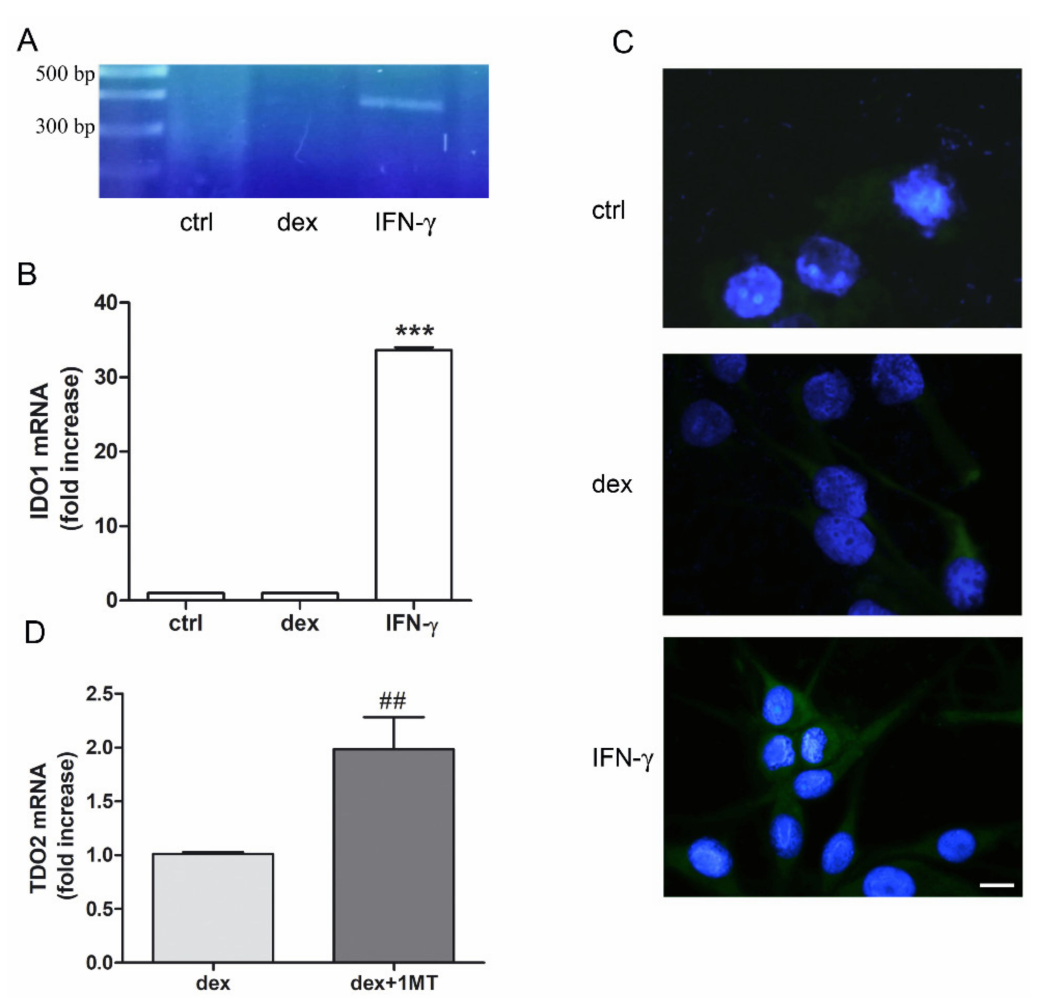
Figure 3. Modulation of IDO1 and TDO2 by interferon gamma (IFN- γ ) or dex. ( A ) Cells were treated without (ctrl) or with dex (25 µ M) or with IFN- γ (50 ng/mL) for 24 h. Total RNA was then isolated, and RT-PCR-generated cDNA of IDO1 was subjected to agarose gel electrophoresis. ( B ) Cells were treated without (ctrl) or with dex (25 µ M) or with IFN- γ (50 ng/mL) for 24 h. Total RNA was then isolated, and real time PCR was performed. Data represent mean ± SEM, ( n = 4; *** p < 0.001 vs. control unstimulated (ctrl) cells). ( C ) Cells were treated without (ctrl) or with dex (25 µ M) or with IFN- γ (50 ng/mL) for 24 h, followed by immunofluorescence for IDO1 expression (IDO1: green; nuclei: blue). Representative photomicrographs at 40 × magnification are shown. Scale bar 20 µ m. ( D ) Cells were treated with dex (25 µ M) in the presence or absence of 40 µ M 1-MT, an IDO inhibitor. Real-time PCR results for TDO2 expression are shown. Data plotted represent mean ± SEM. Increase over dex effect ( n = 6; ## p < 0.01 vs. dex